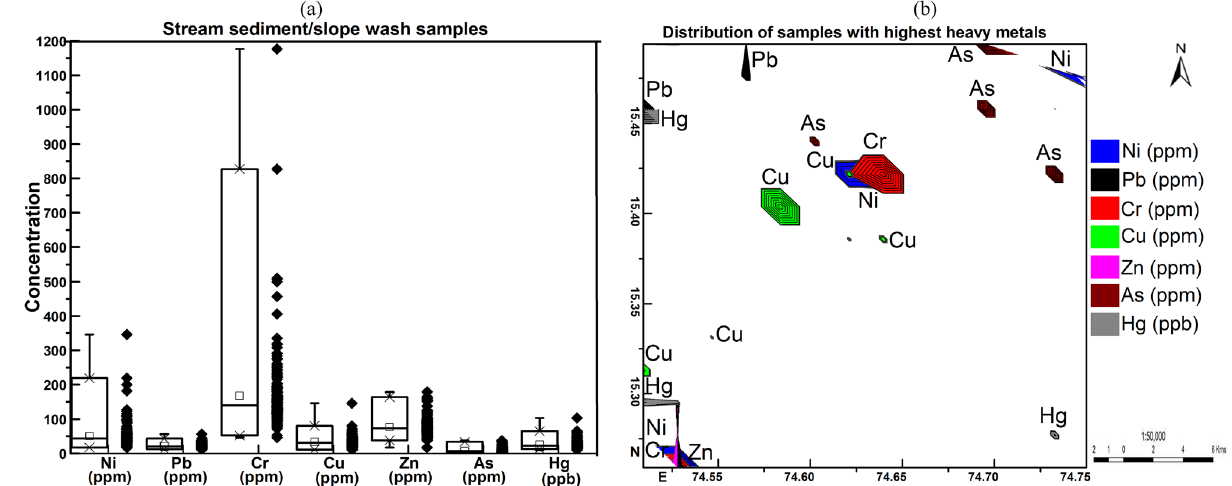
Figure 4. Heavy metal ( a ) concentrations in studied samples, and ( b ) distribution of samples with high metal content in the surface sediment samples of the study